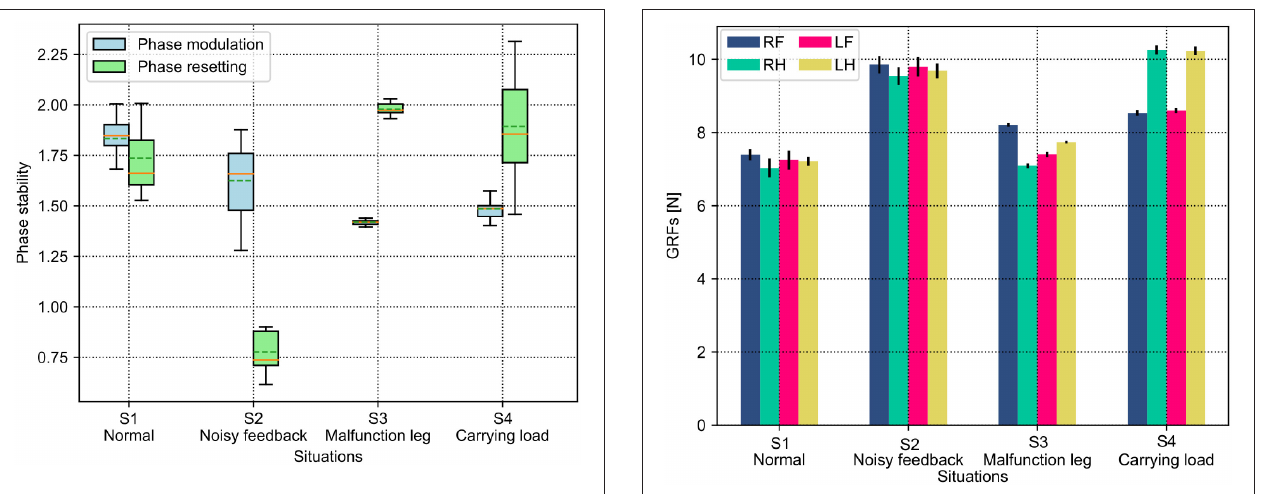
FIGURE 8 | Phase deviation of the self-organized robot locomotion under the PM and PR in the four situations. The solid and dashed lines in the boxes indicate the median and mean values of the phase deviation, respectively.